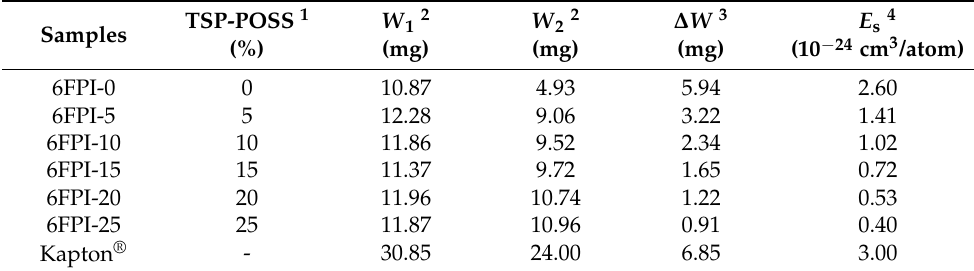
Figure 14. AO erosion yields of the 6FPI-POSS composite films (Insert: Appearance of representative 6FPI-0-AO and 6FPI-25-AO films). Table 4. AO effects and erosion yields for 6FPI/POSS composite